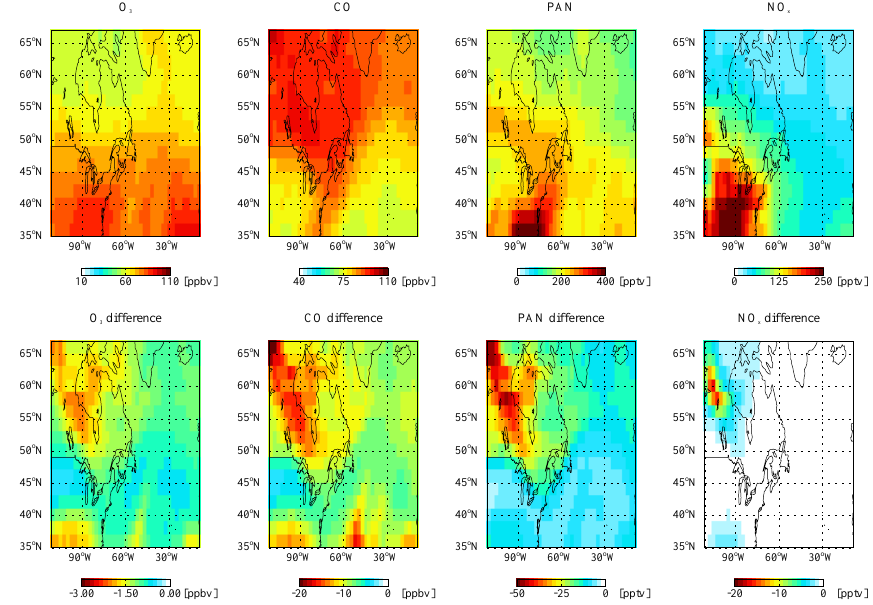
Fig. 12. Model ozone, CO, PAN, and NO x distributions across North America and the North Atlantic at 500hPa averaged over the BORTAS- A campaign period, 12 July to 4 August 2010. The top row shows the mean distributions from the model simulation with the scaled FLAMBE inventory derived from the MOPITT CO inversion. The absolute differences compared to the model outputs with the original FLAMBE emissions are shown in the bottom